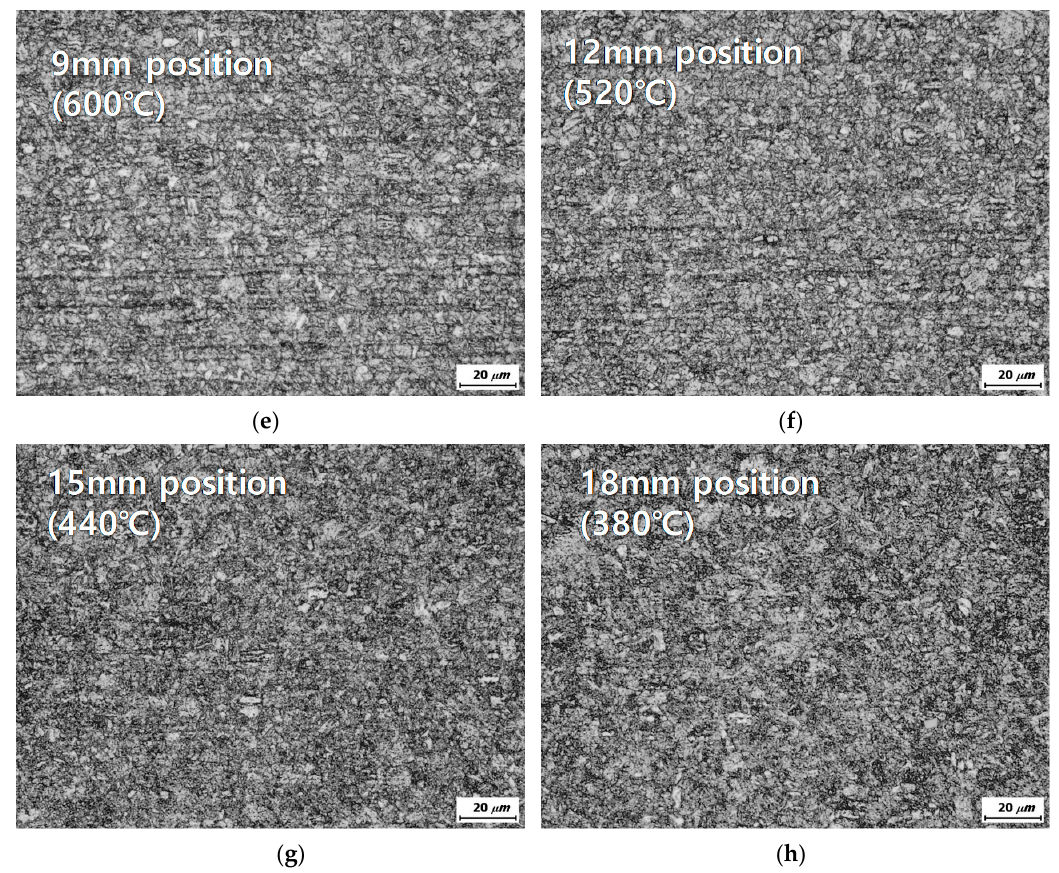
Figure 9. Microstructure observation with respect to heated position: ( a ) As-received material; ( b ) 0 mm position; ( c ) 3 mm position; ( d ) 6 mm position; ( e ) 9 mm position; ( f ) 12 mm position; ( g ) 15 mm position; ( h ) 18 mm position.